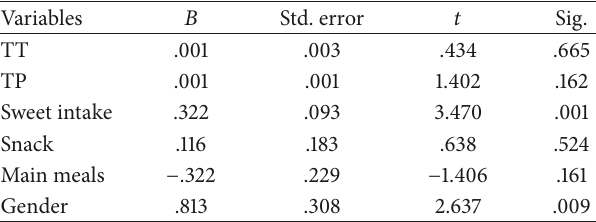
Table 4: Multiple linear regression analysis for factors associated with the beverage sweet intake score